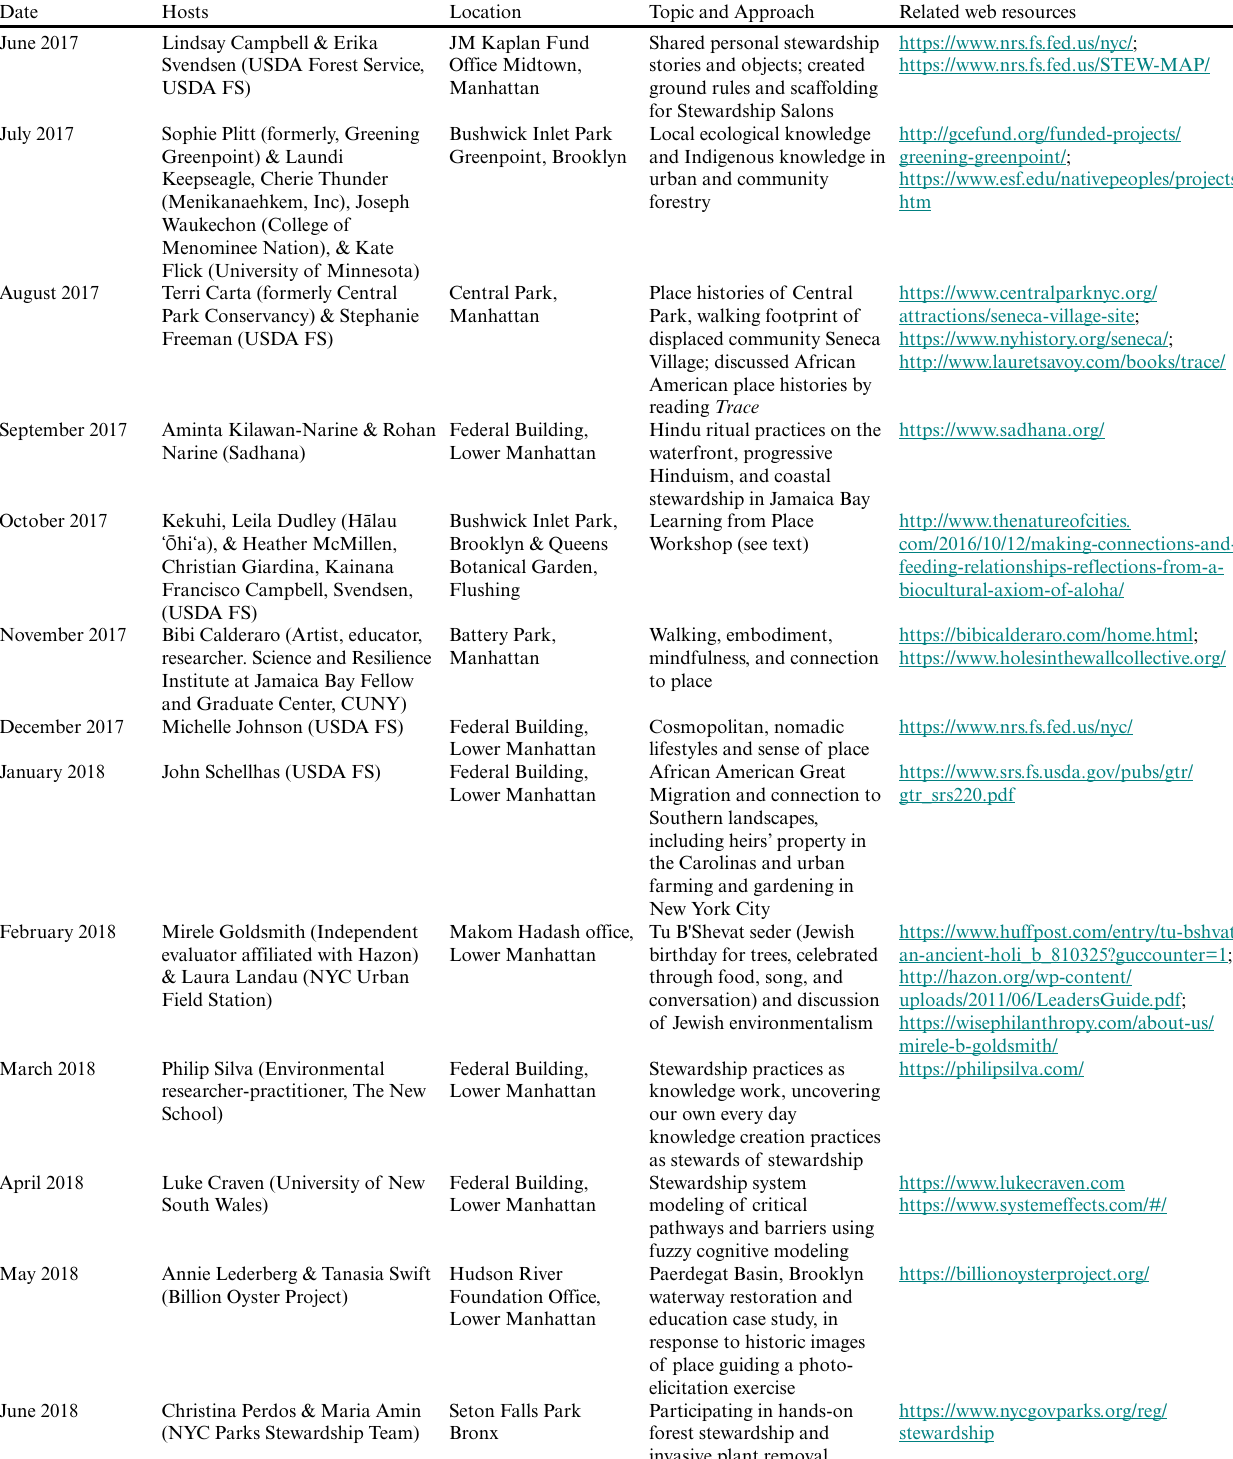
Table 1 . Stewardship Salon dates, hosts, locations, topics, and